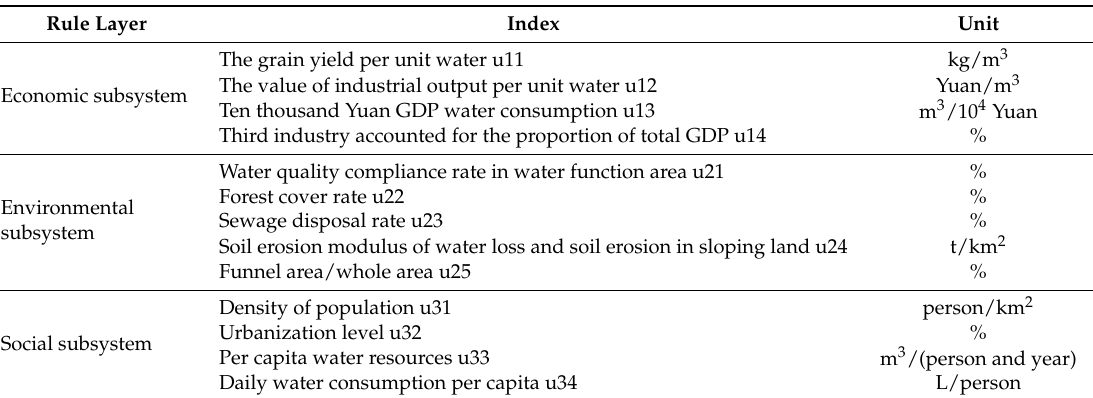
Table 2. Three subsystems, final indicators, and units.